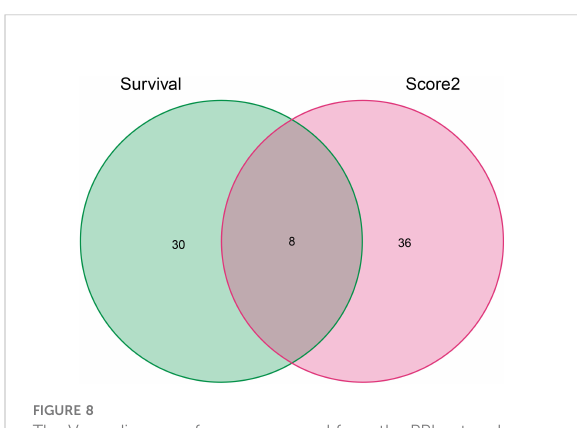
FIGURE 8 The Venn diagram of genes screened from the PPI network above and genes associated with a survival prognosis of lung adenocarcinoma. The green and red ovals represent the identi fi ed prognostic gene and PPI network gene